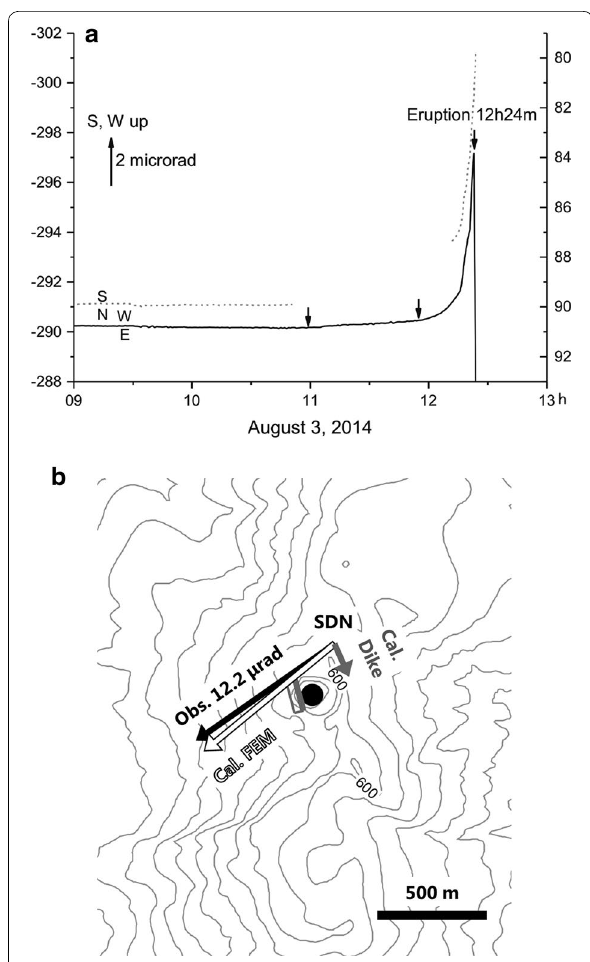
Fig. 11 a Tilt change at SDN on August 3, 2014 (Iguchi et al. 2017). b Observed tilt during 11:00 AM–12:24 PM (the black arrow) and calcu- lated tilt (white and gray arrows) at SDN applying the obtained FEM spherical source (solid circle) and dike (gray rectangle),